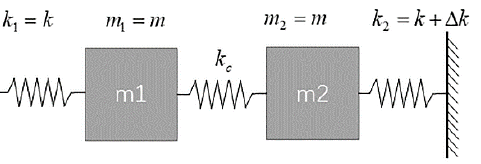
Figure 1. Mass–spring–damper model of a 2-DoF WCRs with external Figure 1. Mass – spring – damper model of a 2-DoF WCRs with external perturbation.